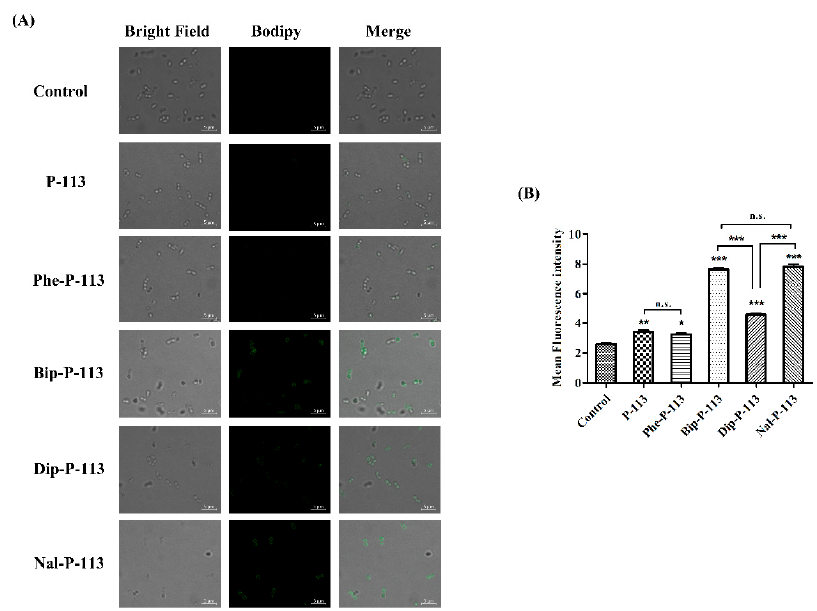
Figure 3. P-113 and its derivatives increase the uptake of BODIPY-labeled vancomycin in E. faecium . ( A ) Fluorescence images of 10 7 CFU/mL E. faecium BCRC 15B0132 treated with 0.5 ×MIC of P-113, Phe- P-113, Bip-P-113, Dip-P-113, and Nal-P-113 at 37 °C for 30 min, then treated BODIPY-labeled vancomycin for 30 min (scale bar represents 5 µm). (B) Mean fluorescence intensity of P-113, Phe-P-113, Bip-P-113, Dip-P-113, and Nal-P-113 treated in E. faecium BCRC 15B0132. Samples treated with BODIPY-labeled vancomycin only served as a control. Results are presented as means ± SEM, * p < 0.05, ** p < 0.01, *** p < 0.001 compared with control. n.s. = no significant differences. The experiments